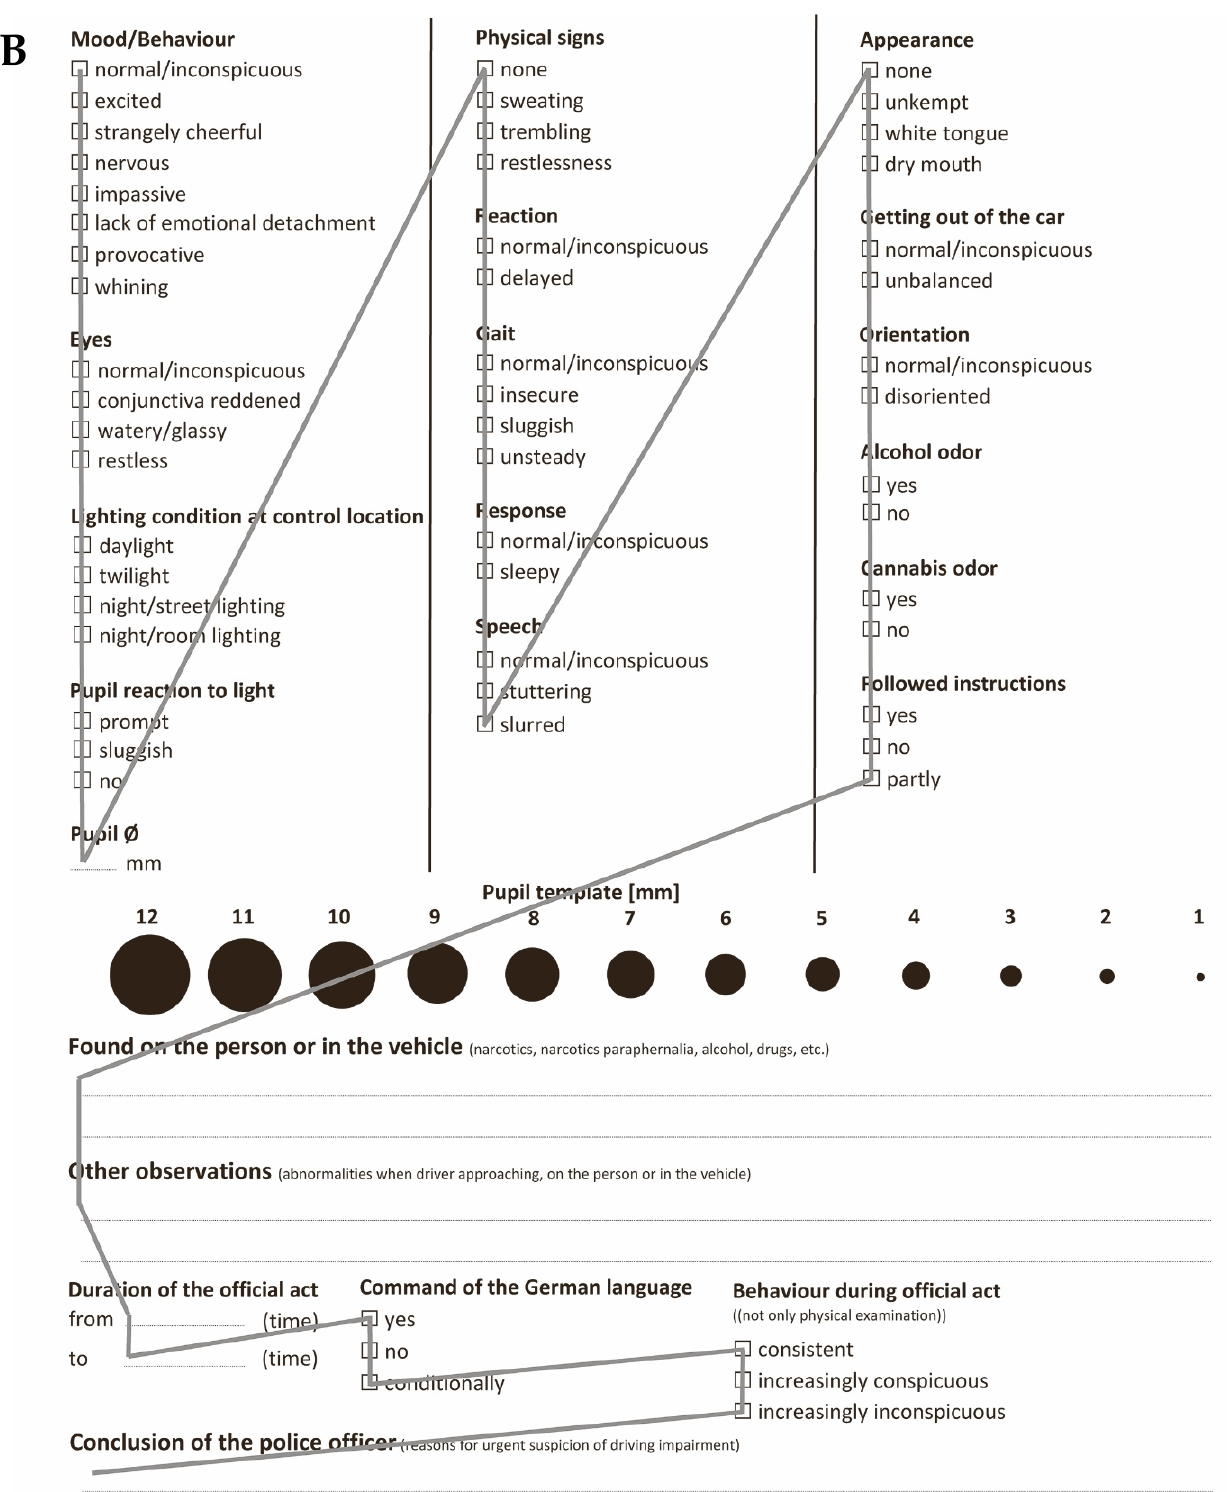
Figure 3. Grey lines represent movement amplitude in the original ( A ) and redesigned ( B ) check- lists.